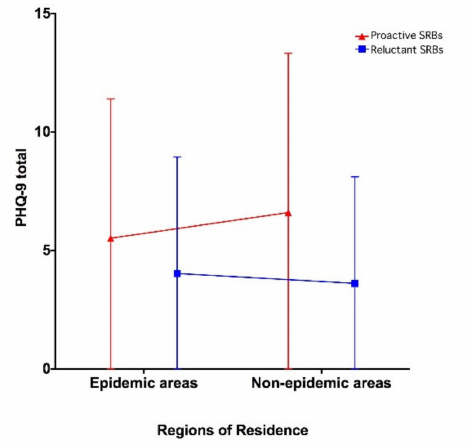
Figure 1. Total score (mean, SD) of Patient Health Questionnaire-9 (PHQ-9) for all participants ( n = 1053). PHQ-9 varies with regions of residence (epidemic areas/non-epidemic areas) and proactive/reluctant self-restraint behavior (SRB). There is a significant interaction between regions of residence and the degree of SRB (F(1,1049)= 4.061, p = 0.044) and a significant main effect of the degree of SRB (F(1,1049)= 36.157, p < 0.001). There is a significant difference in PHQ-9 scores between proactive and reluctant SRB in non-epidemic areas in that participants with proactive SRB show higher PHQ-9 total scores than compared to those reluctant toward